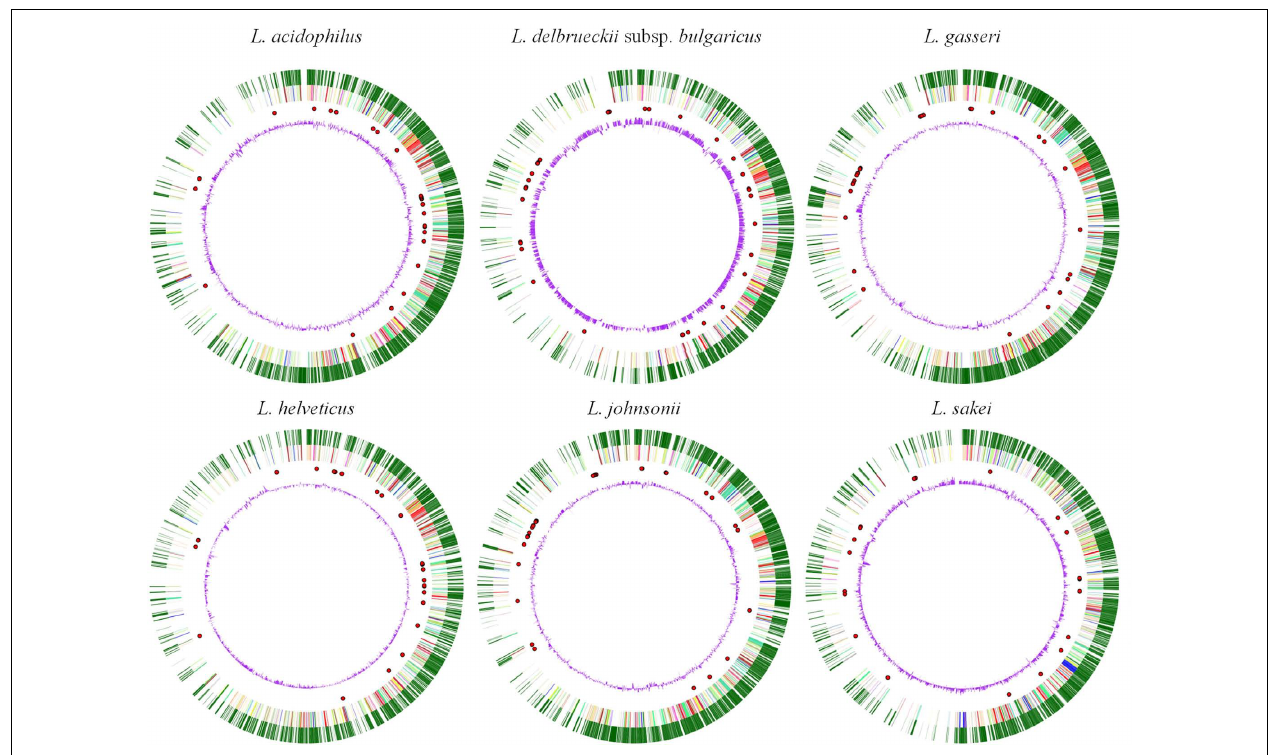
FIGURE 3 | Image of the six Lactobacillus species compared ( L. acidophilus NCFM, L. delbrueckii subsp. bulgaricus ATCC11842, L. gasseri ATCC 33323, L. helveticus DPC 4571, L. johnsonii NCC533, L. sakei 23 K) generated by Microbial GenomeViewer. From outside to inside: genes, COG categories, tRNA, GC%.